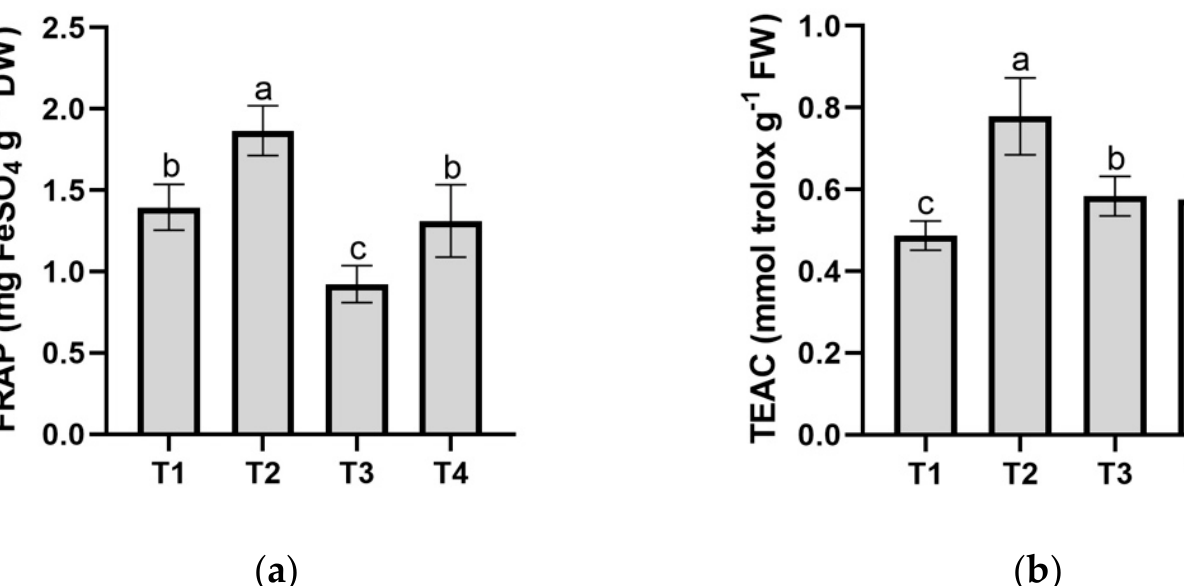
Figure 3. FRAP ( a ) and TEAC ( b ) values in spears from the four different plots: untreated control (T1), Brassica pellets (T2), chicken manure pellets (T3), and Dazomet (T4). Values are expressed as means ± standard error ( n = 9). Bars marked with different letters indicate significant differences among genotypes based on the LSD 0.05 test ( p <